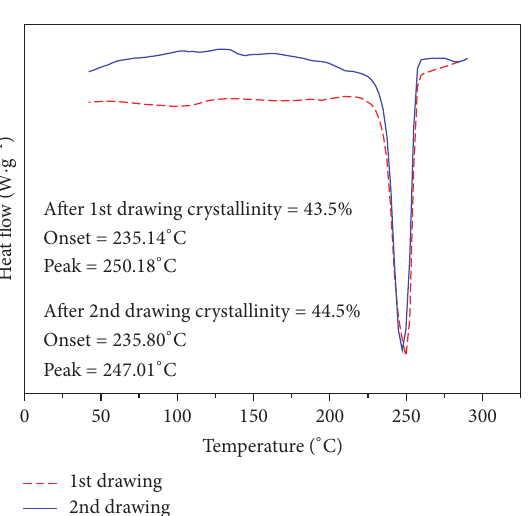
Figure 10: The effect of drawing temperature on mechanical properties of PET after the first drawing